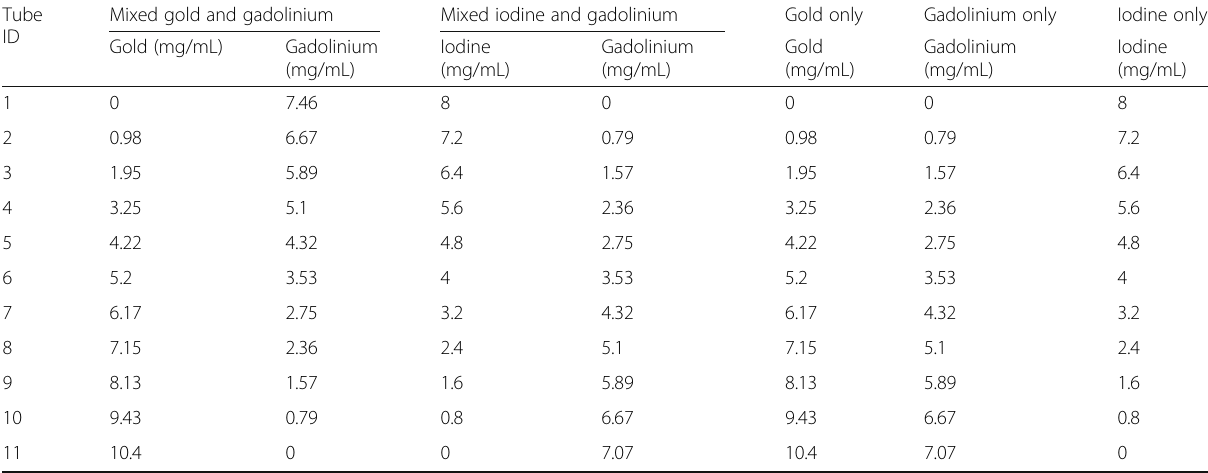
Table 1 Concentrations of the three different contrast agents used in mixtures or individually diluted to obtain the six sets of 11 tubes Tube